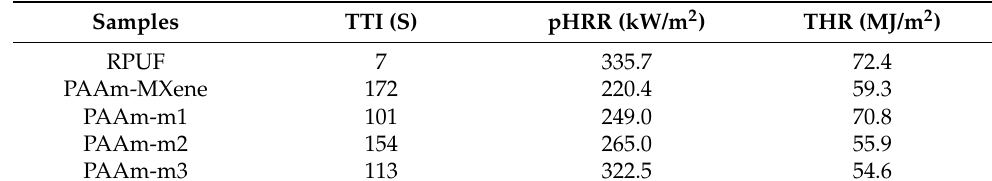
Table 1. The data of pure RPUF and Coated RPUF cone calorimetry test.